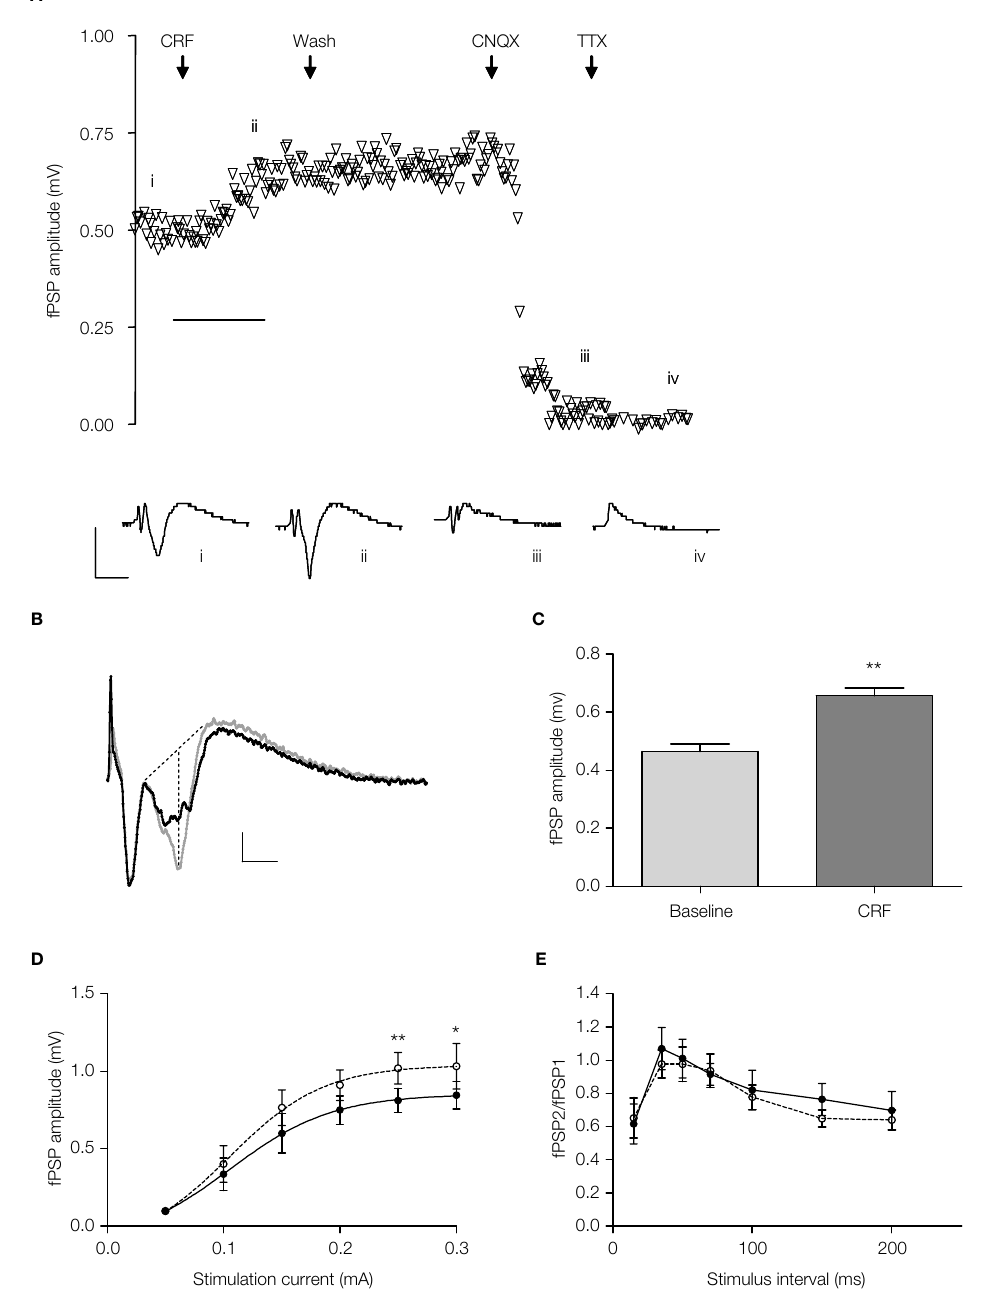
Figure 3 | (A) Timecourse of fPSP amplitude and example traces (i) at baseline, (ii) following application of CRF (0.1 μ M), (iii) following washout of the CRF and application of CNQX (10 μ M), and (iv) following application of TTX (100 nM). Each symbol represents the fPSP amplitude for a single response. Horizontal scale bar 10 min. (B) Example of evoked fi eld potentials before (black trace) and after (grey trace) the application of CRF (0.1 μ M); the non-biological component that was not sensitive to TTX applied at the end of the experiment has been digitally removed. Dotted lines indicate the method for determining the fPSP amplitude. (C) The mean fPSP amplitude evoked by currents at 60–80% of maximum at baseline and after 15 min incubation with CRF (0.1 μ M). Amplitude was determined from responses similar to that shown in (B) . ** p < 0.01, paired t -test, n = 7 slices, 5 rats. (D) Stimulus current-response relationship for evoked fPSPs in the absence ( (cid:122) ) and presence ( (cid:123) ) of CRF (0.1 μ M), statistical analysis was carried using a two-way repeated measures ANOVA (see text) followed by a post-hoc Bonferroni test ( * p < 0.05, ** p < 0.01, n = 7 slices, 5 rats). (E) Paired-pulse relationship for evoked fPSPs in the absence ( (cid:122) ) and presence ( (cid:123) ) or CRF (0.1 μ M), statistical analysis was carried out using a two-way repeated-measures ANOVA (see text; n = 8 slices, 5 rats).